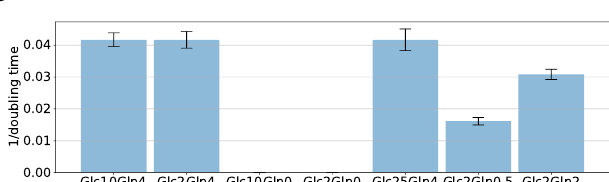
Figure 3. In-silico biomass flux predictions and observed proliferation growth rates. Maximal in silico biomass flux predictions for U2OS across the specific models created for each condition based on transcriptomic data (GEM-RAS) * ( a ), nutrient availability data (GEM-MUR) * ( b ), transcriptomic data and nutrient availability data (GEM-RAS-MUR) * ( c ), transcriptomic data from the condition Glc25Gln4 and nutrient availability data (GEM-RAS(Glc25Gln4)-MUR) ( d ). ( e ) Reciprocal of the cells’ doubling time calculated from a linear equation describing the change in cell number over the time **. * No data for conditions Glc10Gln0 and Glc2Gln0 because cells were not able to survive and the RNA could not be isolated. ** For Glc10Gln0 and Glc2Gln0 the doubling time was not available because the growth rate was less than or equal to